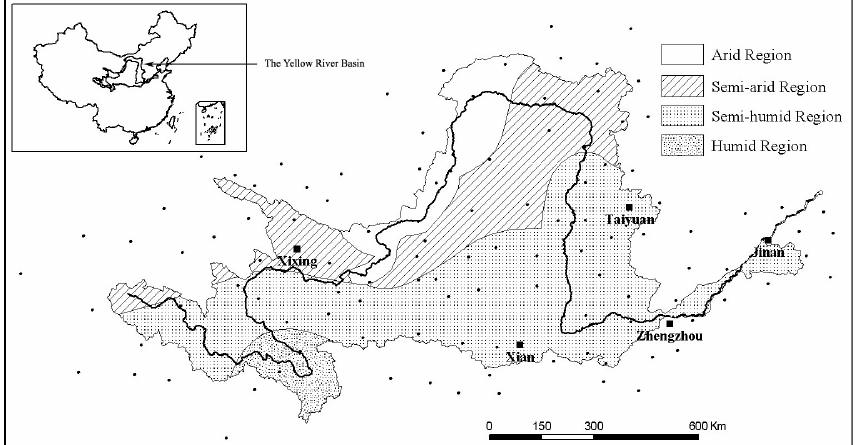
Fig. 1. The Yellow River